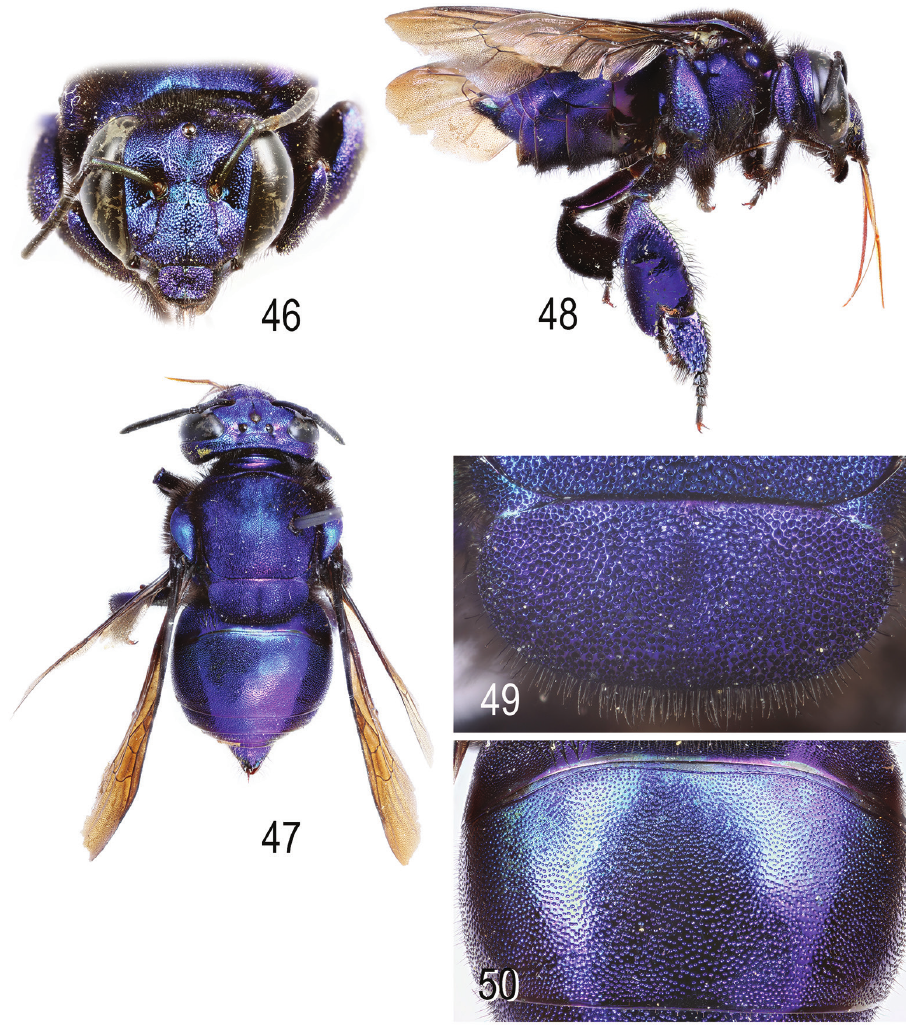
Figures 46–50. Female of E. coerulescens (Mexico: San Luis Potosí, ECO-TAP-E-104161; Querétaro, ECO-TAP-E-104753 [Fig. 46]). 46 Facial view 47 Dorsal habitus 48 Lateral habitus 49 Dorsal view of mesoscutellum 50 Second metasomal